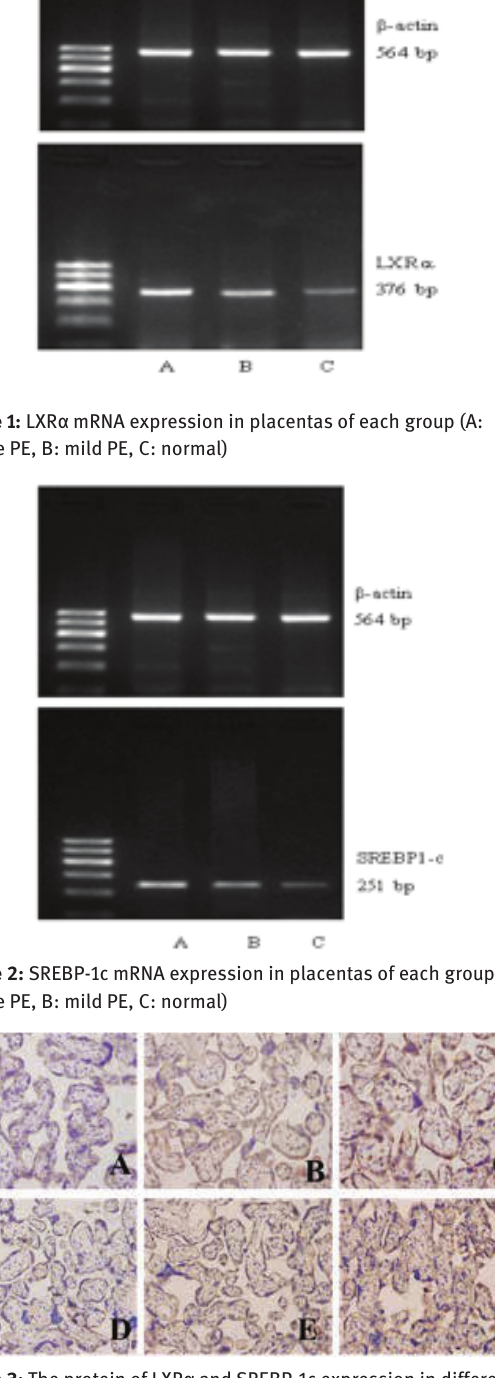
Figure 3: The protein of LXRα and SREBP-1c expression in different tissue (A: LXRα protein expression in placenta of a normal preg- nancy; B: LXRα protein expression in a mild PE placenta; C: LXRα protein expression in a severe PE placenta; D: SREBP-1c protein expression in placenta of a normal pregnancy; E: SREBP-1c protein expression in a mild PE placenta; F: REBP-1c protein expression in a severe PE